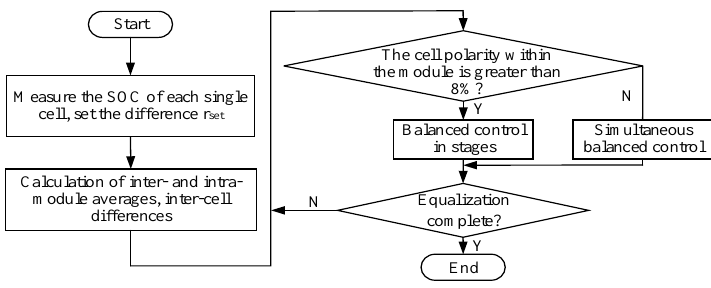
Figure 6. Equalization control flow chart.